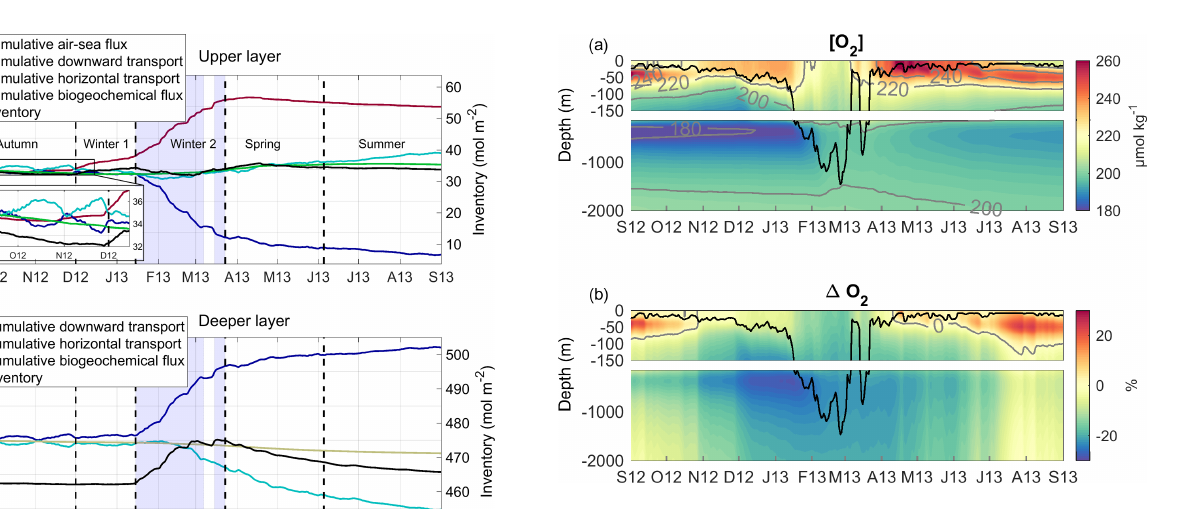
Figure 9. Time evolution of (a) the dissolved oxygen concentra- tion (µmolkg − 1 ) and (b) the oxygen saturation anomaly (%), with mixed-layer depth (m) indicated by the black line, all horizontally averaged over the deep-convection